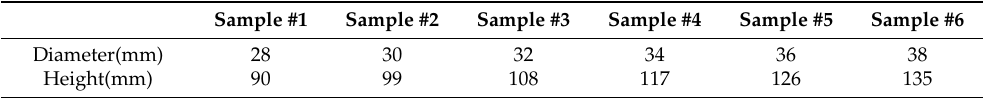
Figure 6. The E-textile sensor measures the resistance change according to stretch rate: ( a ) Graph of resistance change according to elongation rate; ( b ) Measurement of resistance according to stretch rate; ( c ) Change in length from 100% to 200% at a fixed point; ( d ) Mock-up sample sensor measurement schematic diagram; ( e ) Mock-up samples produced according to size. Table 1. Mockup sample